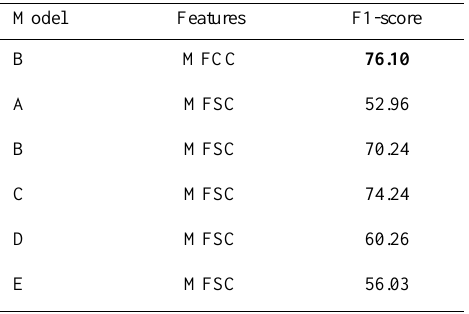
Table 7. Results comparison between MFCC and MFSC